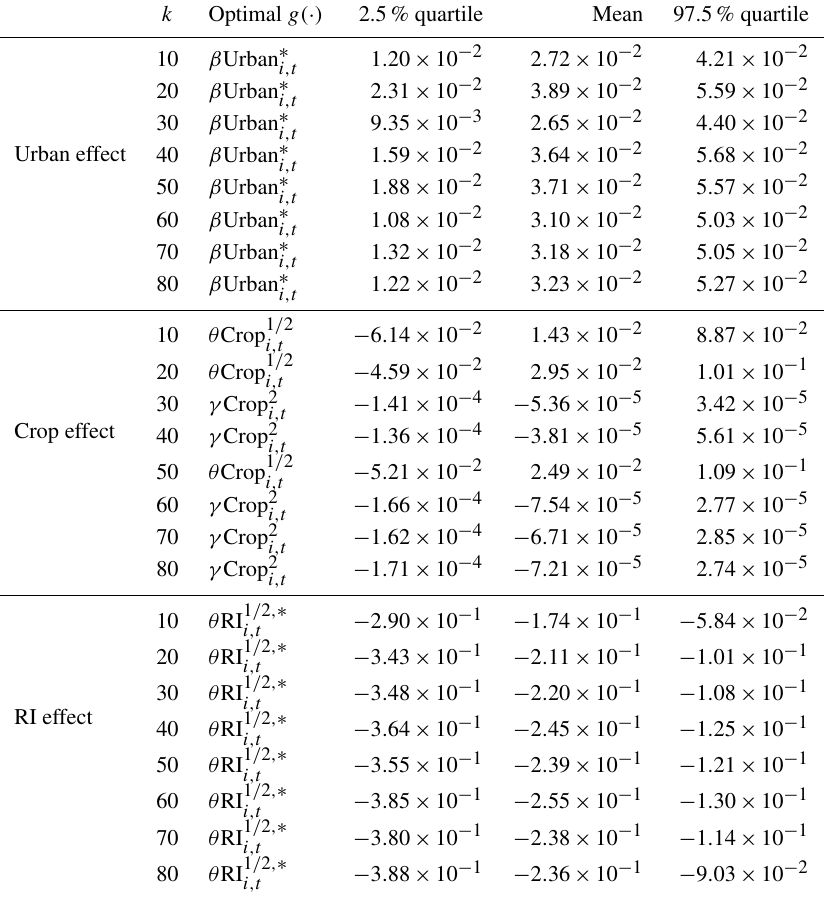
Table 2. Optimal regression forms (with the lowest AIC) and the corresponding coefficient estimations of factor urban percentage (Urban), cropland percentage (Crop), and reservoir index (RI) in Eq. (1). The ∗ denotes that the coefficient does not equal 0 at a 0.05 significance level using bootstrapping inference; k is the preset number of catchment